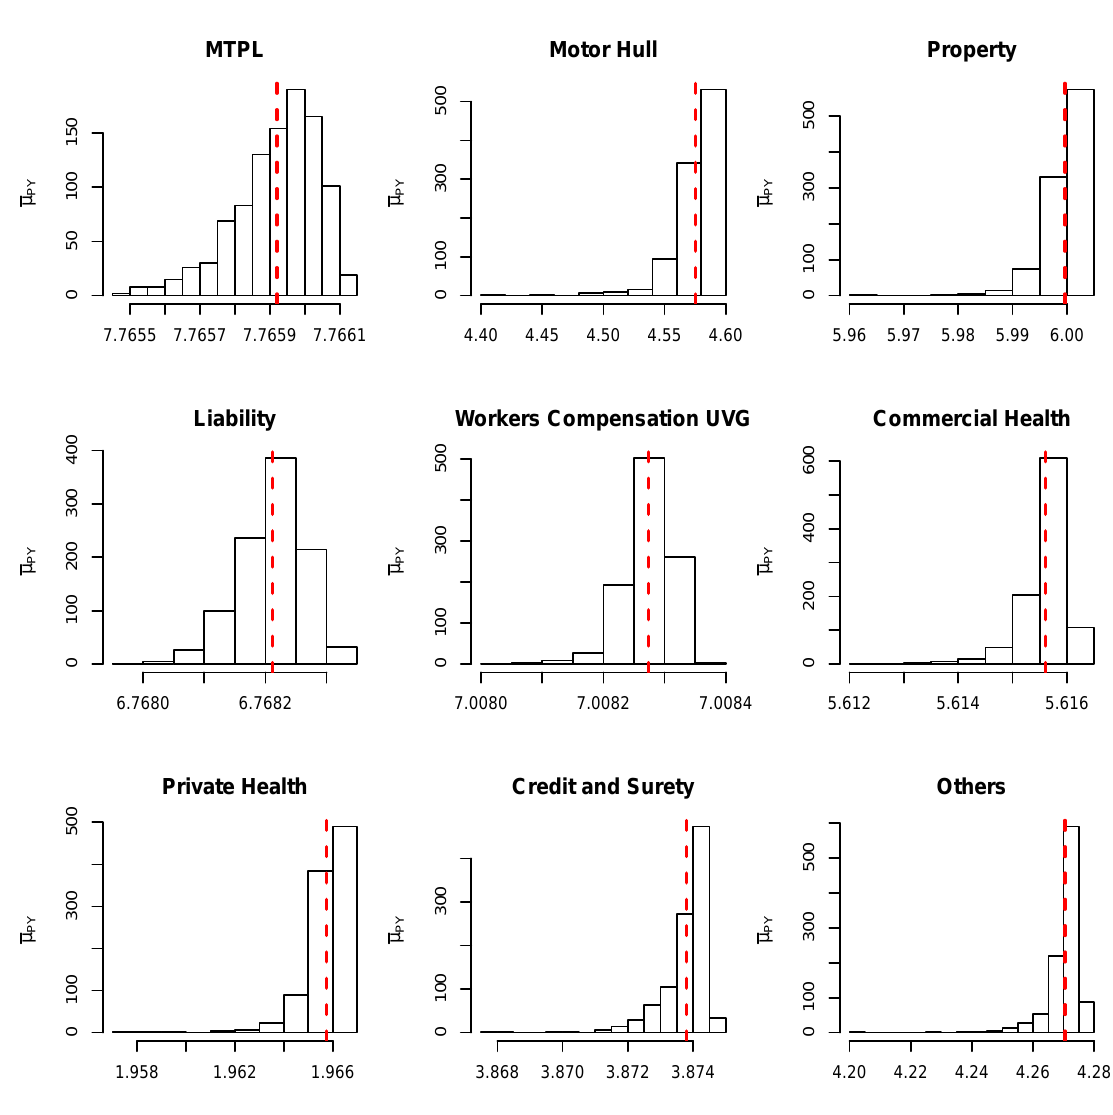
Figure 6. Histogram of the parameter µ for the conditional model. Red dashed line: µ PY . PY For each of the LoBs the plots on the Figures 9 and 10 show the relative bias, defined